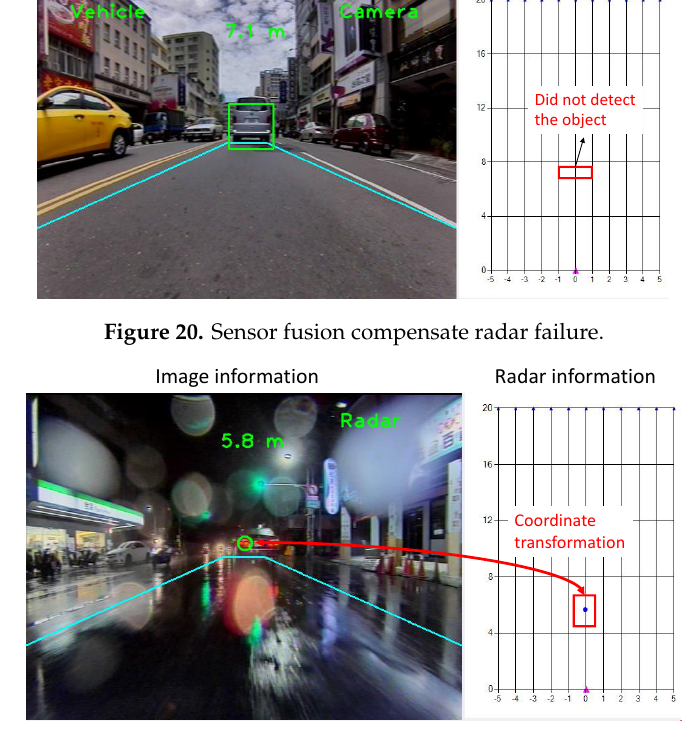
Figure 21. Sensor fusion compensate for image failure.